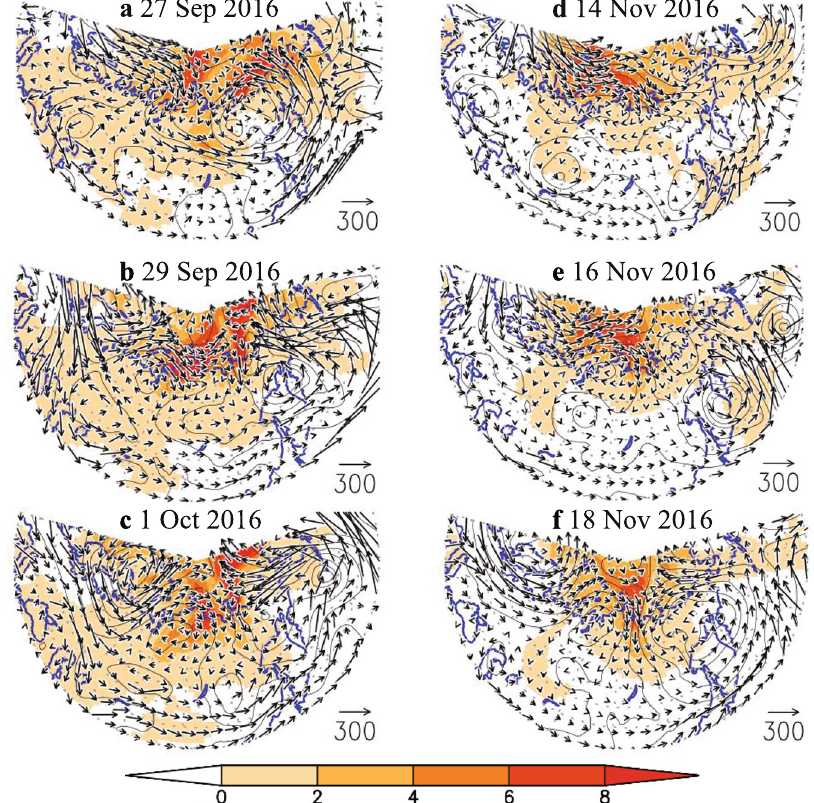
Fig. 6 Pathways of Arctic moisture. Geopotential height at 850 hPa (contour, m) with 60-m intervals and column-integrated water vapor fl ux (vector, kg m − 1 s − 1 ) during events of high transportation of Arctic moisture. Shading illustrates the distribution of Arctic moisture